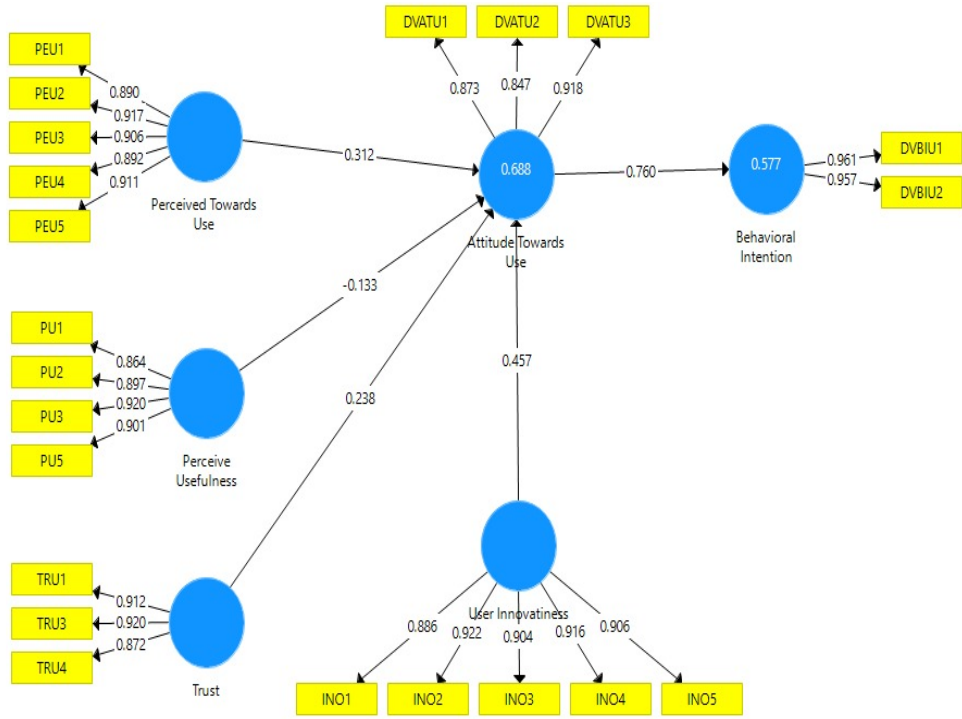
Figure 3. PLS algorithm analysis of the measurement model. Table 2. Convergence